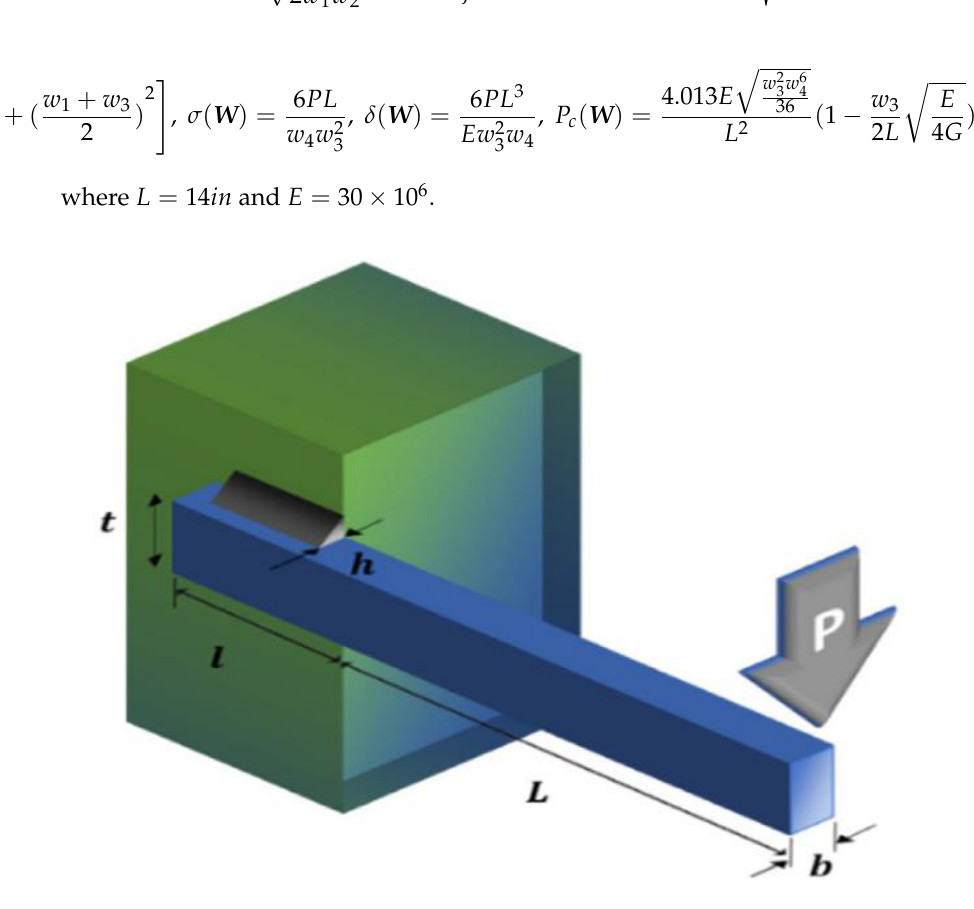
Figure 10. Structure of WB.